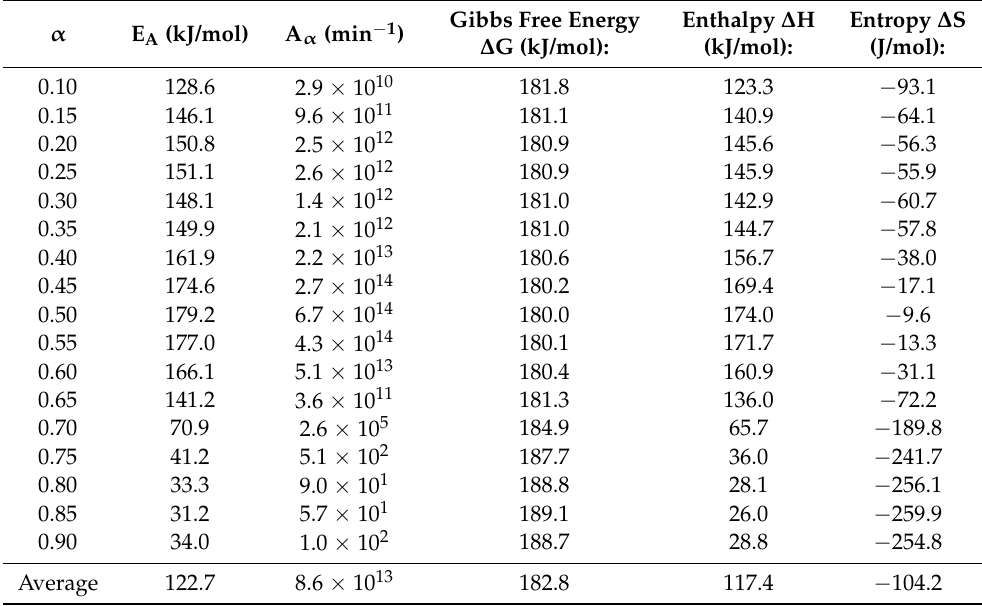
Table 4. Apparent activation energy (E A ) by the Starink model, pre-exponential factor (A α ) by the Kissinger method, and thermodynamics properties for pyrolysis of